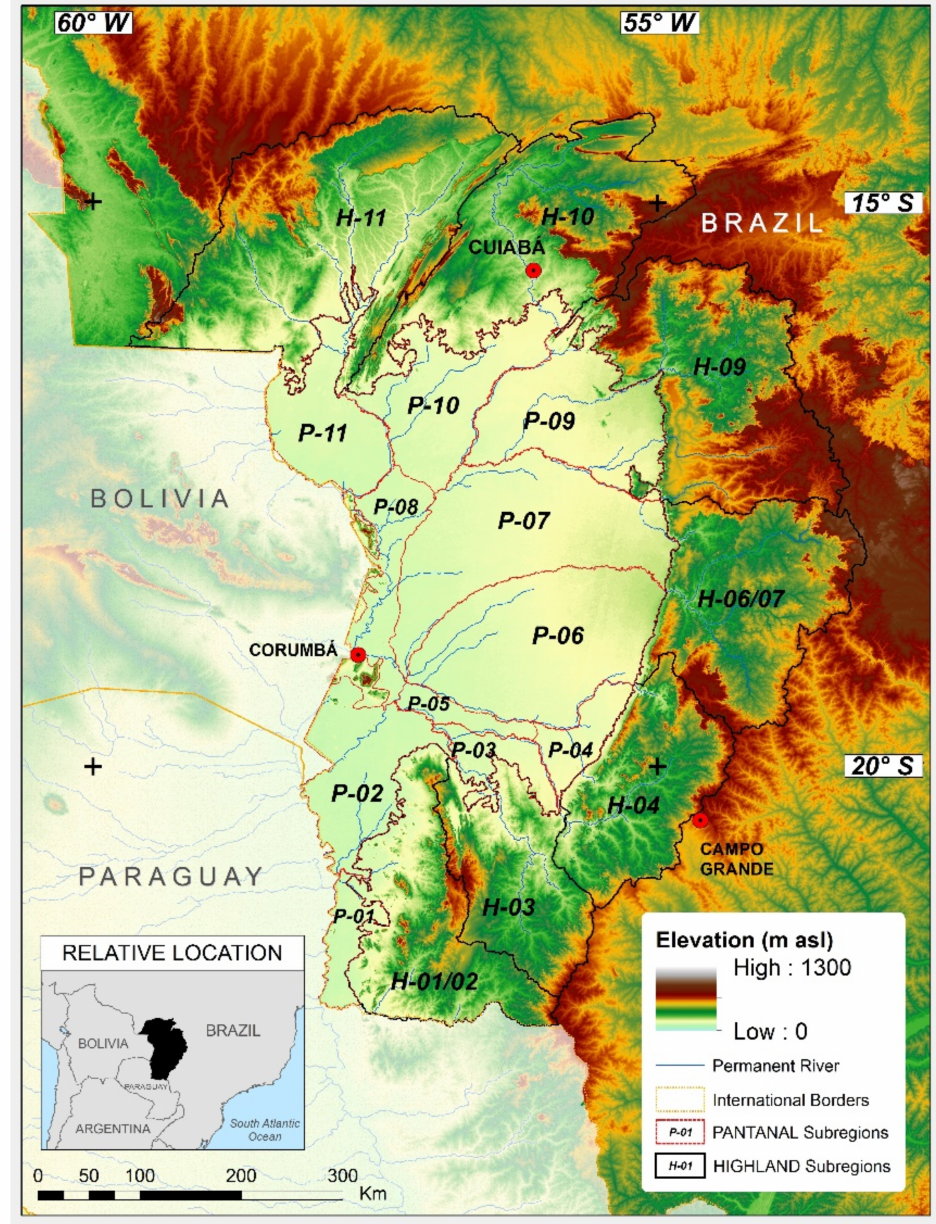
Figure 1. Map of the study area of the Upper Paraguay River Basin (UPRB) encompassing the Pantanal and the surrounding Highlands. Pantanal sub-regions are: Porto Murtinho (P-01), Nabileque (P-02), Miranda (P-03), Aquidauana (P-04), Abobral (P-05), Nhecol â ndia (P-06), Paiagu á s (P-07), Paraguai (P-08), Bar ã o de Melgaço (P-09), Pocon é (P-10) and C á ceres (P-11), and were taken from Silva and Abdon [29]; while Highland sub-regions (H-01/02, H-03, H-04, H-06/07, H-09, H-10 and H-11), draining to the different Pantanal sub-regions, were adapted from Thielen et al.